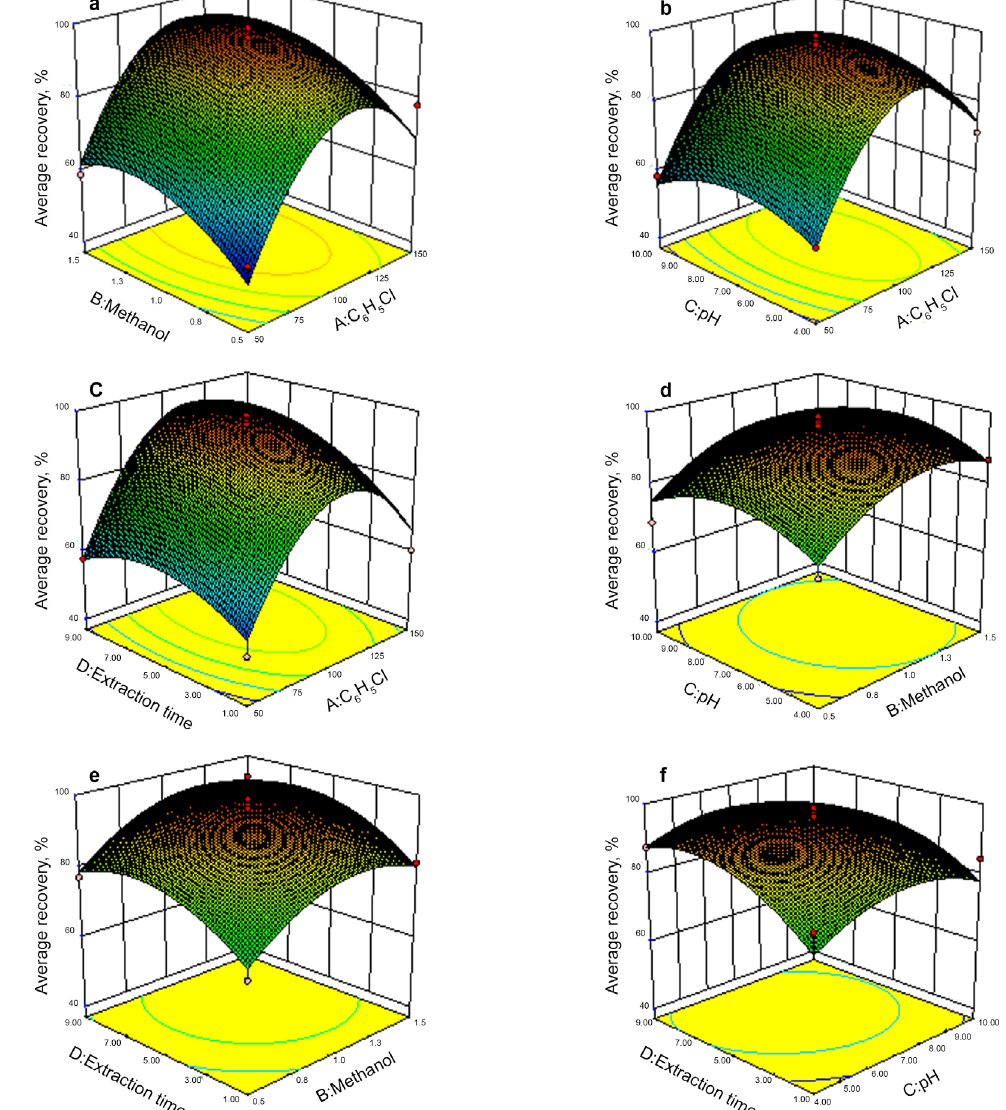
H Cl volume and methanol volume; b) pH and C 6 5